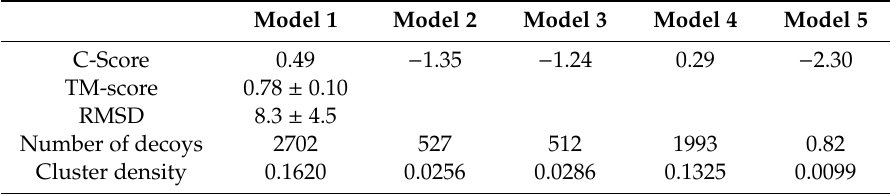
Table 2. C-score, TM-Score, and root mean square deviation (RMSD) of the models generated by the I-TASSER tool.